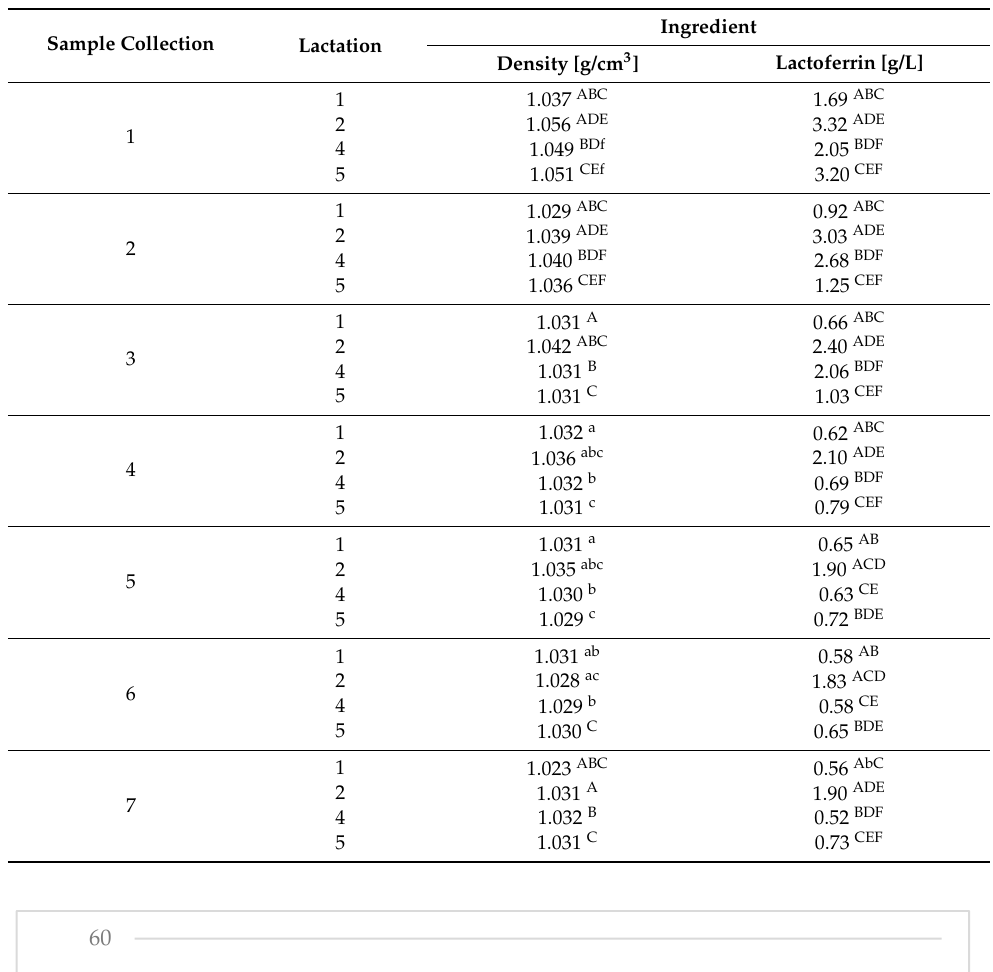
Table 2. Changes in lactoferrin and density values for colostrum over subsequent collection, depend- ing on parity. Data are presented as least squares means. Means marked with the same letters differ significantly at: lowercase letters, p ≤ 0.05; uppercase letters, p ≤ 0.01.